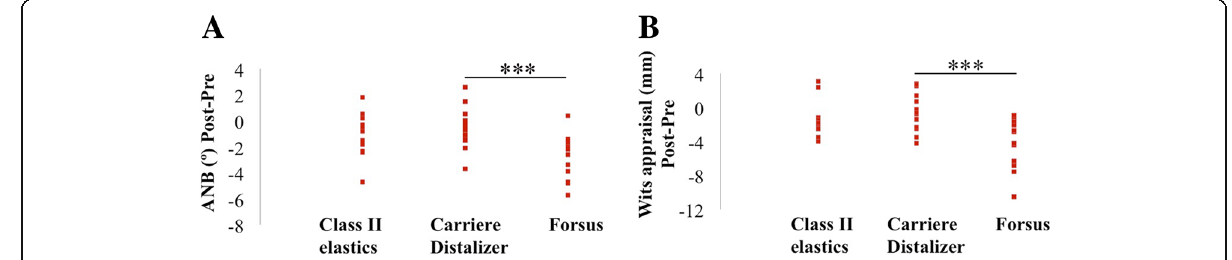
Fig. 5 a , b Pre- and post-treatment differences in ANB and Wits appraisal. * P < 0.05, ** P < 0.01, *** P <